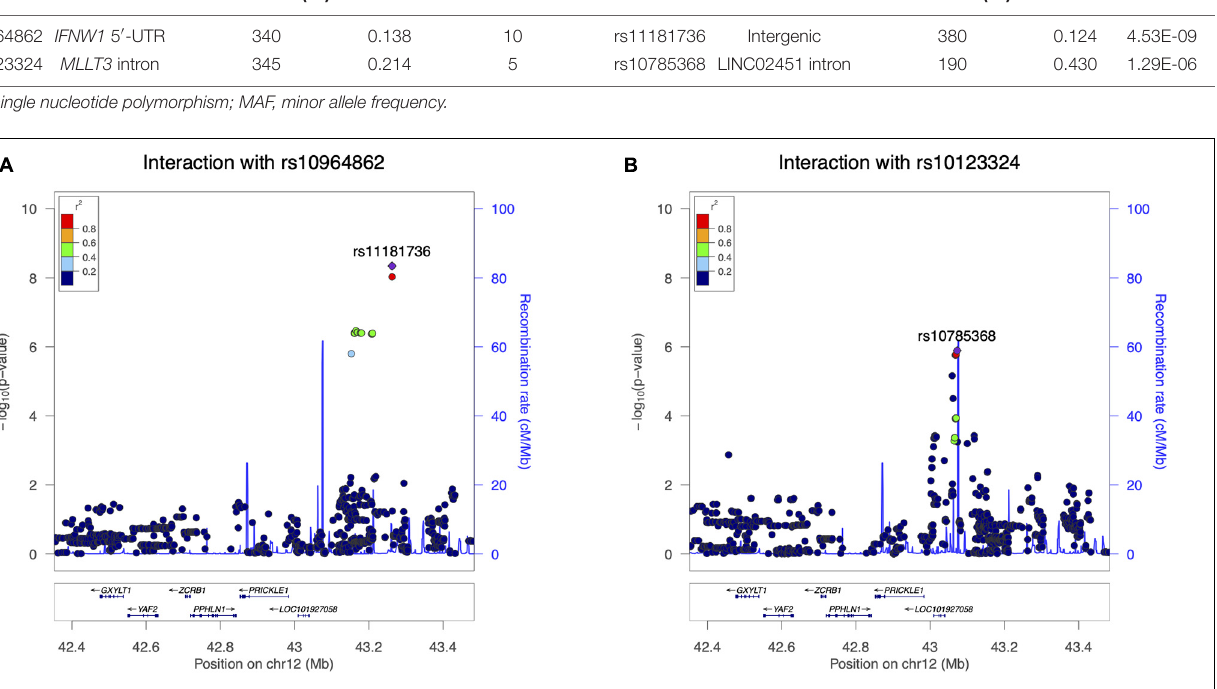
FIGURE 6 | Significant loci in the locus-level replication analysis of FOCAD × PRICKLE1 . (A) –log10( p -value) of the interaction between rs10964862 ( FOCAD locus) and single nucleotide polymorphisms (SNPs) at the PRICKLE1 locus in the replication cohort. (B) –log10( p -value) of the interaction between MLLT3 intronic rs10123324 and SNPs at the PRICKLE1 locus in the replication cohort.